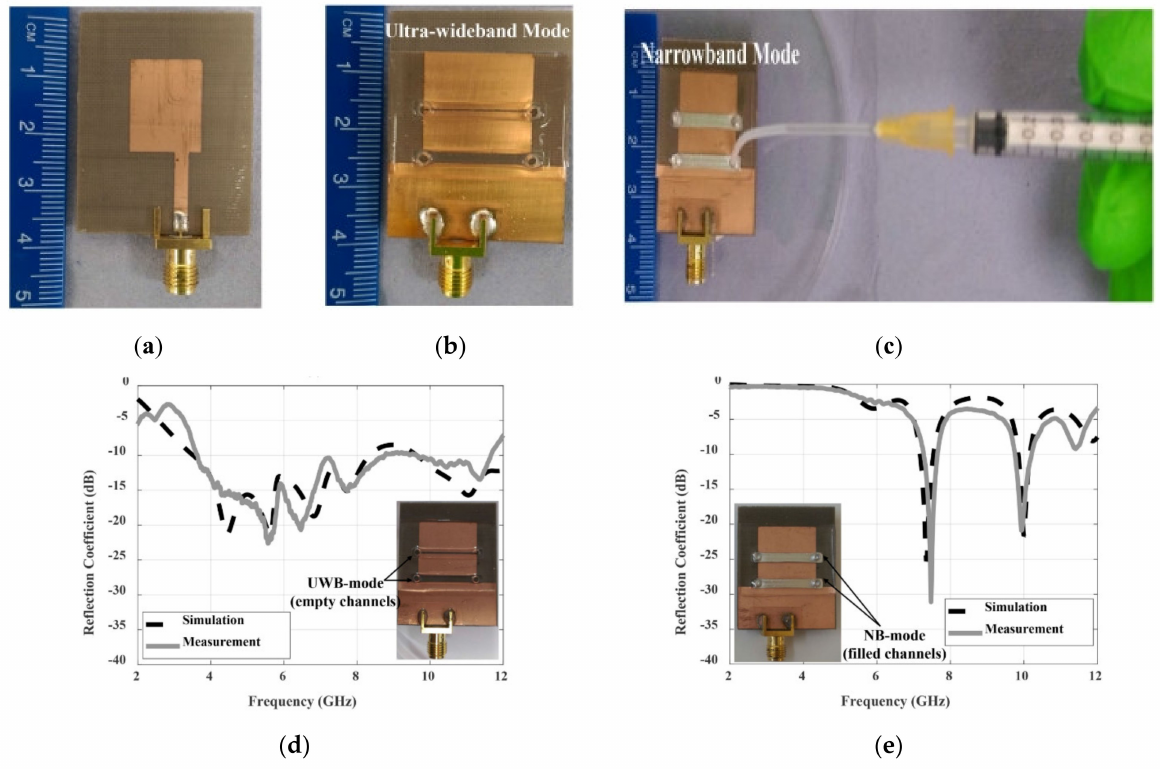
Figure 9. ( a ) Front view of the fabricated antenna. ( b ) Rear view of UWB mode. ( c ) Rear view of NB mode. ( d ) Reflection coefficient of UWB operating state. ( e ) Reflection coefficient of NB operating state. Reprinted with permission from Ref. [44]. Copyright 2020